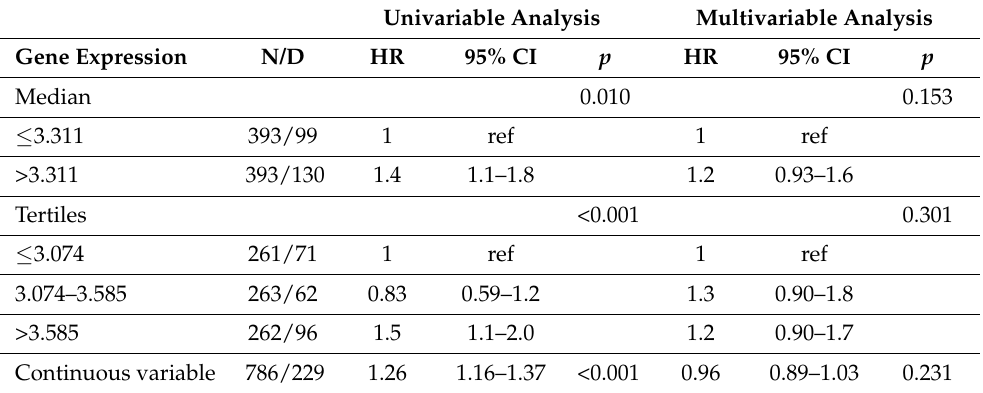
Table 23. Overall Survival of 786 NB patients in relation to NBAS expression levels evaluated by the Cox regression model.